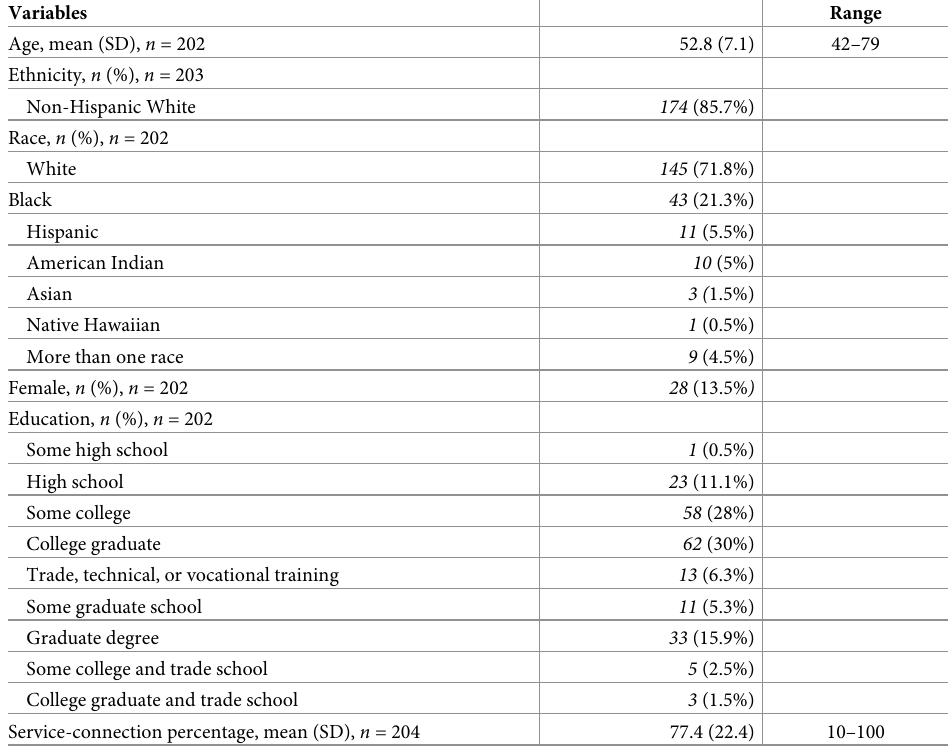
Table 1. Descriptive statistics for the demographic and health characteristics for the N = 204